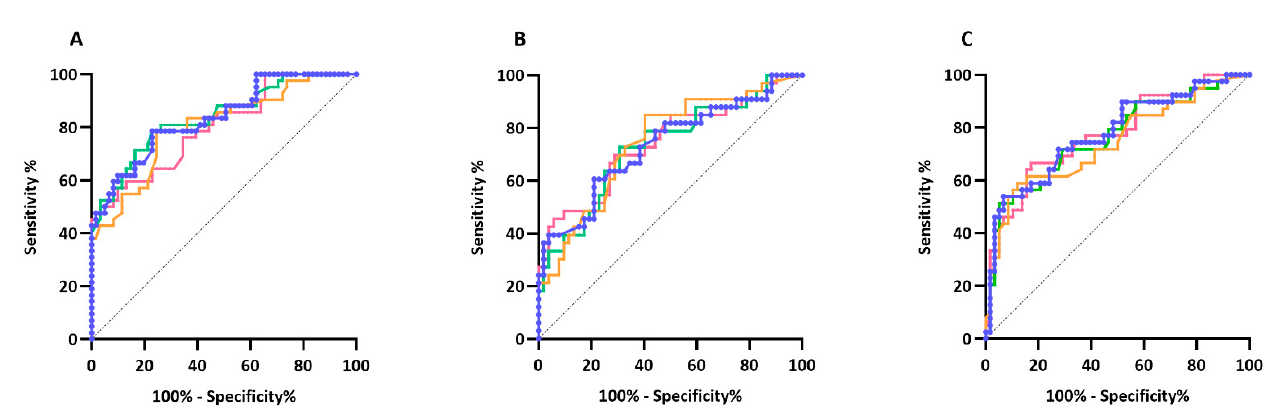
8 of 12 Figure 2. Group mean H wave amplitude responses to stimulus train at ( A ) 1 Hz, ( B ) 2 Hz and ( C ) 3 Hz in control subjects (black circle/black line), patients with painful diabetic neuropathy (red circle/red line) and patients with painless diabetic neuropathy (green circle/green line). Significance values detailed in Table 2. 3.3. ROC Curve Analysis To determine the optimal cut-off for HRDD between patients with and without pain, a ROC curve analysis was undertaken for both individual stimulus responses and average